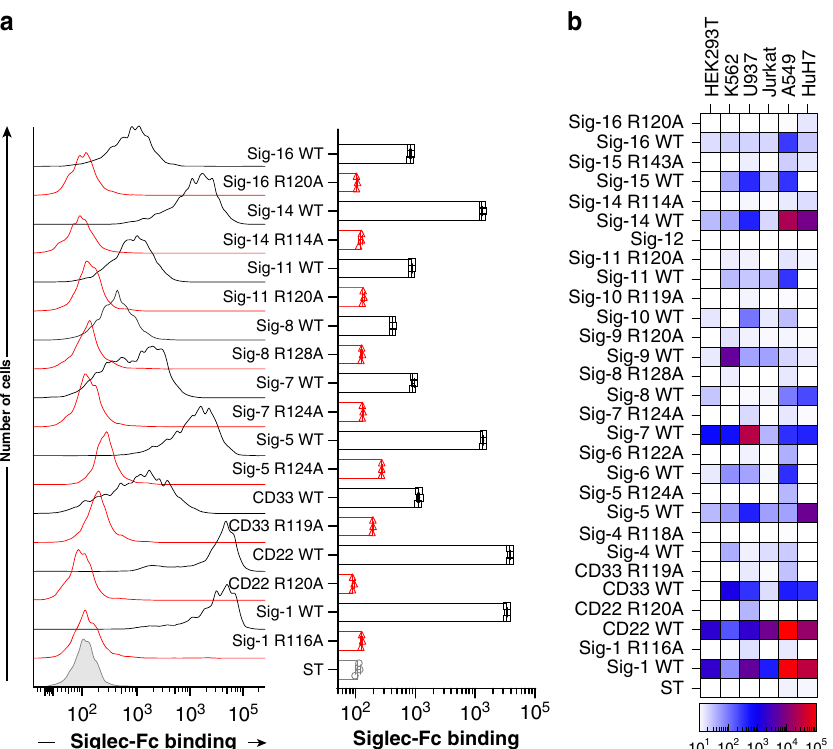
Fig. 2 Using Siglec-Fc proteins to pro fi le Siglec ligands on cell lines. a Flow cytometry data of Siglec-Fc constructs pre-complexed with Strep-Tactin- AF647 binding to A549 cells. Error bars represent ± standard deviation of three replicates. b Heat map of binding of pre-complexed Siglecs to HEK293T, K562, U937, Jurkat, A549, and HuH7